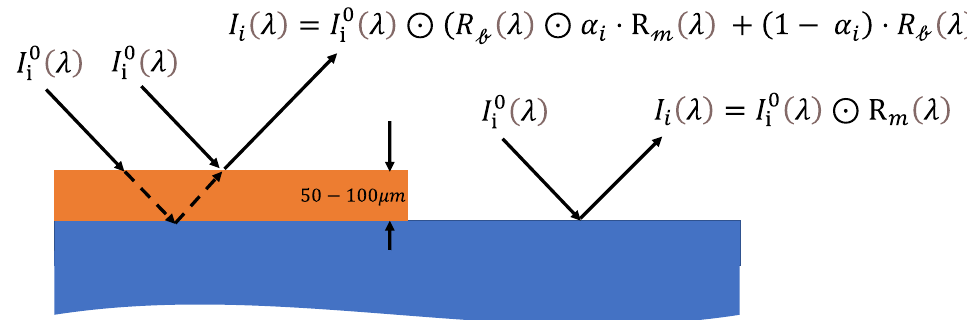
Figure 1. Left: An illustration of the nonlinear mixing between the reflectance spectrum from a thin (sub- millimeter) layer of the target material (red rectangle) and the spectrum arising from the background material (blue rectangle) placed behind the target material. Right: same without the target material